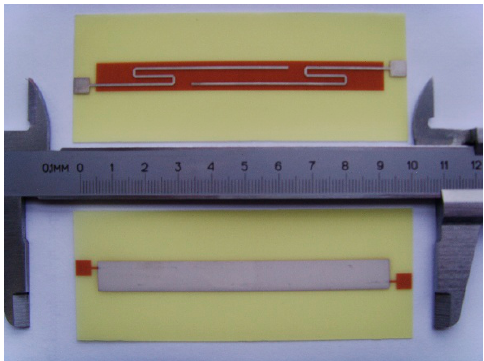
Figure 7. A photograph of the first central board without the metallized holes.